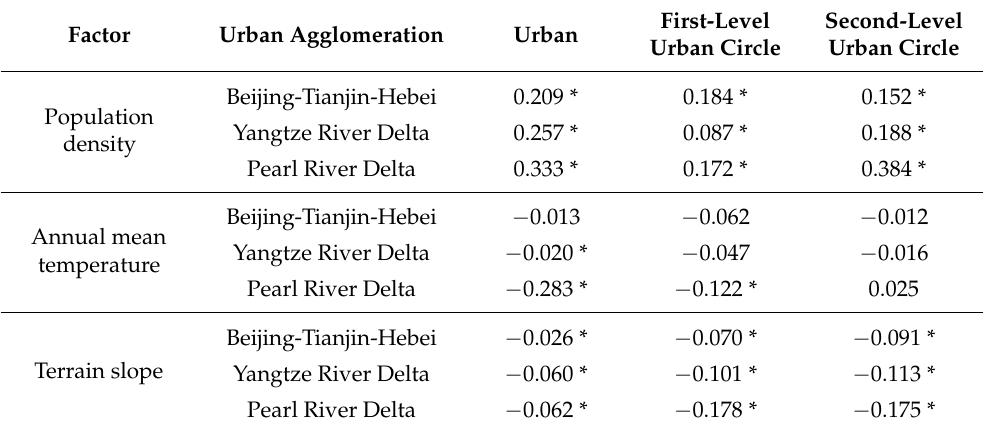
Table 2. Relationships between CO 2 emissions and population density, annual mean temperature and terrain slope among urban circles, such as urban area, first-level urban circle and second-level urban circle. First-Level Second-Level Factor Urban Agglomeration Urban Urban Circle Urban Circle Beijing-Tianjin-Hebei 0.209 * 0.184 * 0.152 * Population Yangtze River Delta 0.257 * 0.087 * 0.188 * density Pearl River Delta 0.333 * 0.172 * 0.384 * Beijing-Tianjin-Hebei − 0.013 − 0.062 − 0.012 Annual mean Yangtze River Delta − 0.020 * − 0.047 − 0.016 temperature Pearl River Delta − 0.283 * − 0.122 * 0.025 Beijing-Tianjin-Hebei − 0.026 * − 0.070 * − 0.091 * Terrain slope Yangtze River Delta − 0.060 * − 0.101 * − 0.113 * Pearl River Delta − 0.062